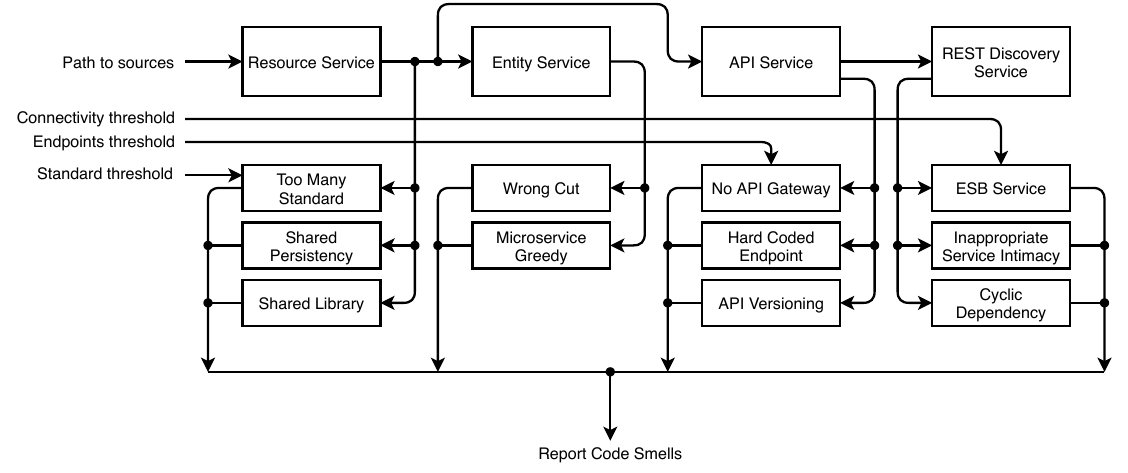
Figure 4. MSANose architecture